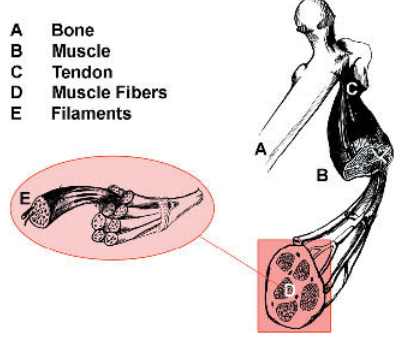
Figure 1. Anatomy of a Skeletal Muscle Individual bundles of muscle fi bers are called fascicles. The cell membrane surrounding the muscle cell is the sarcolemma, and beneath the sarcolemma lies the sarcoplasm, which contains the cellular proteins, organelles, and myofi brils. The myofi brils are composed of two major types of protein fi laments: the thinner actin fi lament, and the thicker myosin fi lament. The arrangement of these two protein fi laments gives skeletal muscle its striated appearance.